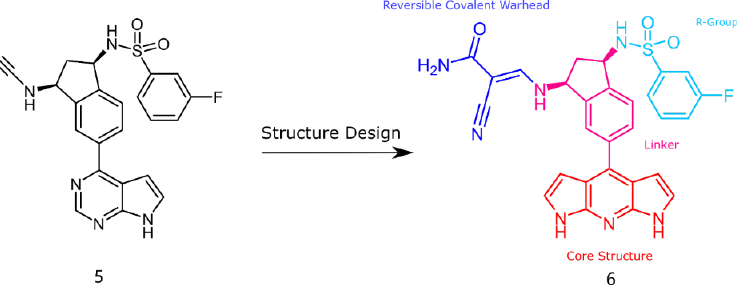
Figure 3. Inhibitor 6 was obtained by replacing the reversible covalent warhead and redesigning the core structure. core structure.